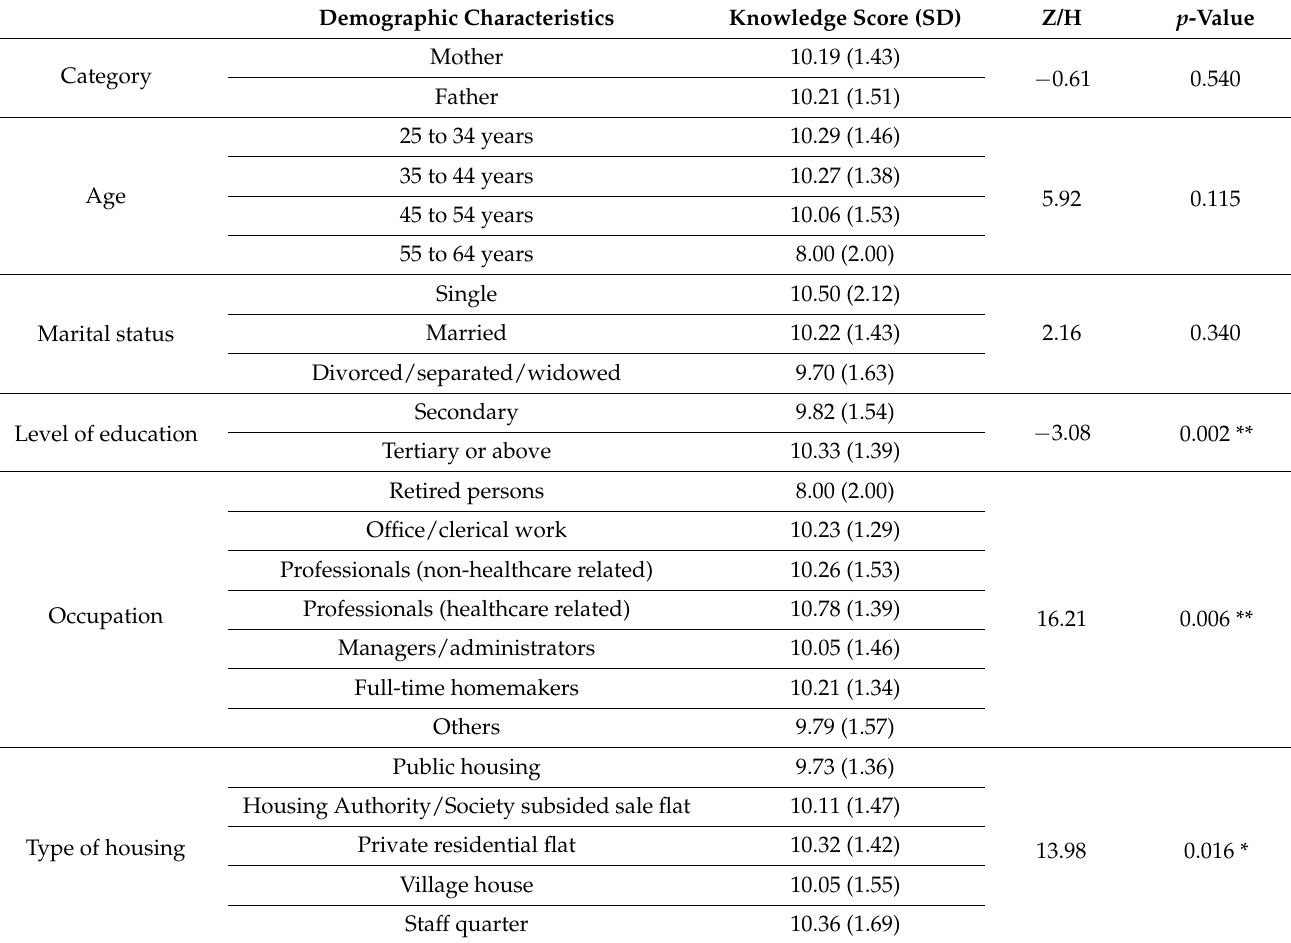
Table 3. Association of knowledge score and demographic